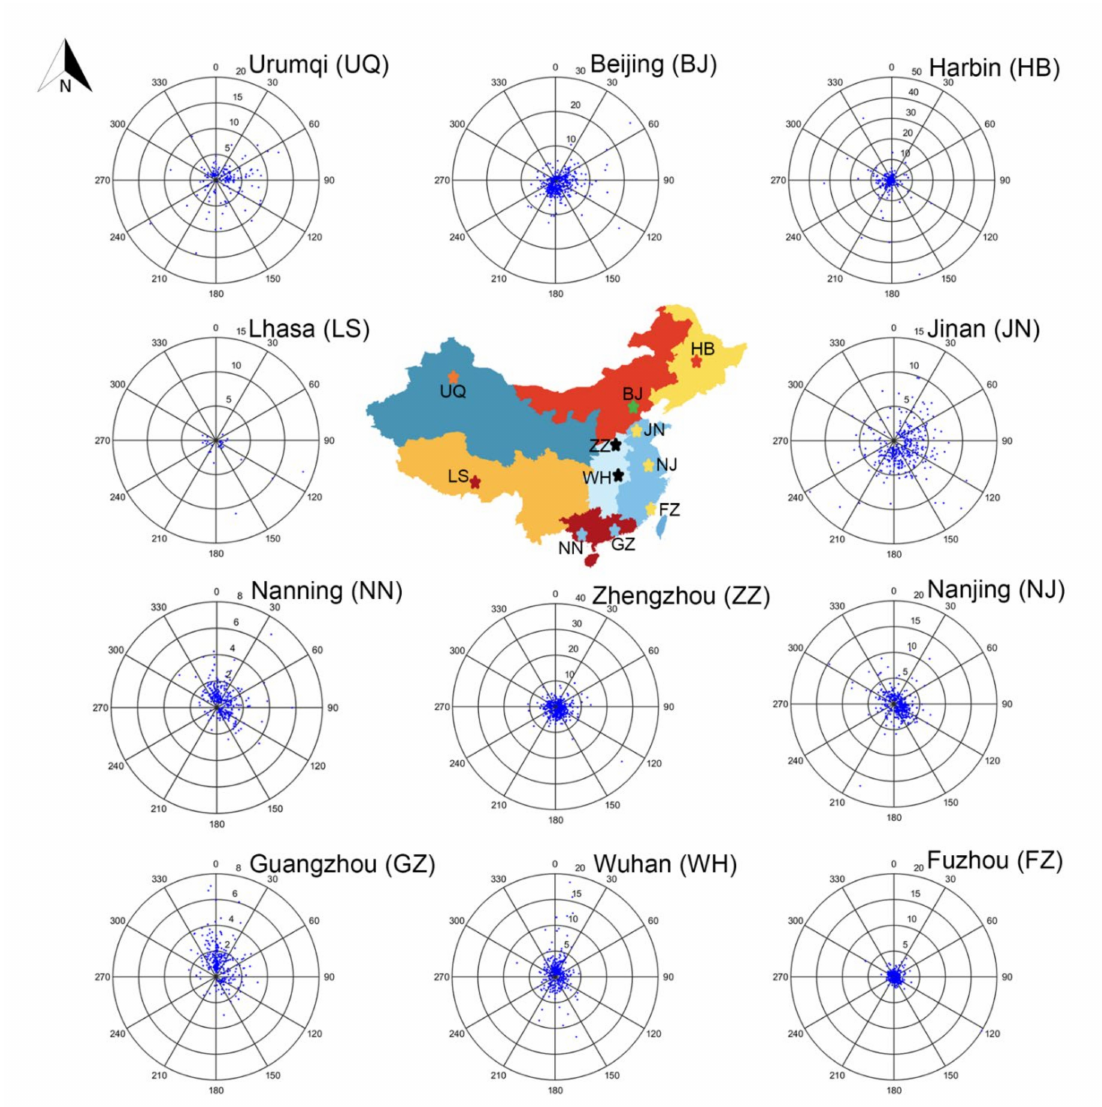
Figure 11. Scatter-plots of wind direction (degree, ◦ ) and PMRR in the 11 cities, and the inserted numbers between 0 and 30 degree are the scale values of